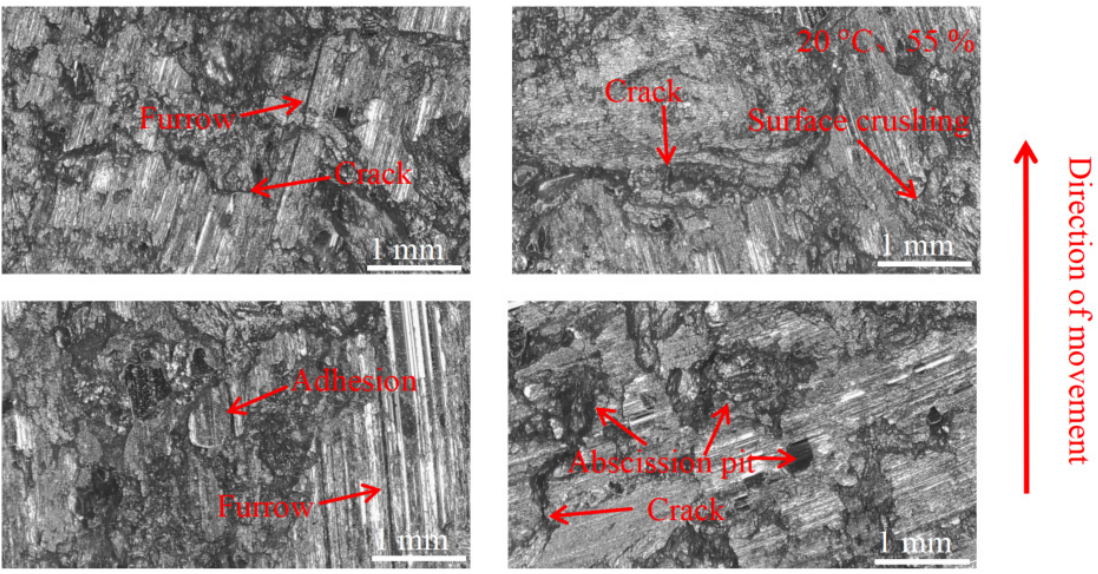
Figure 18. Surface morphology damage map of brake pad at 20 °C and 55% ambient humidity.